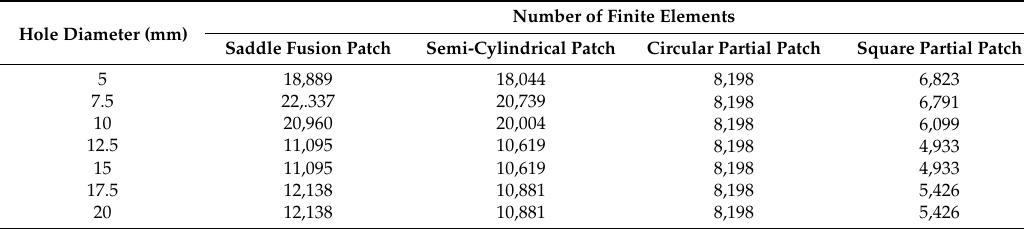
Figure 9. Curves for maximum Von Mises stresses in various patch arrangements for unburied pipe and patch arrangement. Table 5. Number of finite elements used to model unburied pipe and its patch for various patch arrangements.